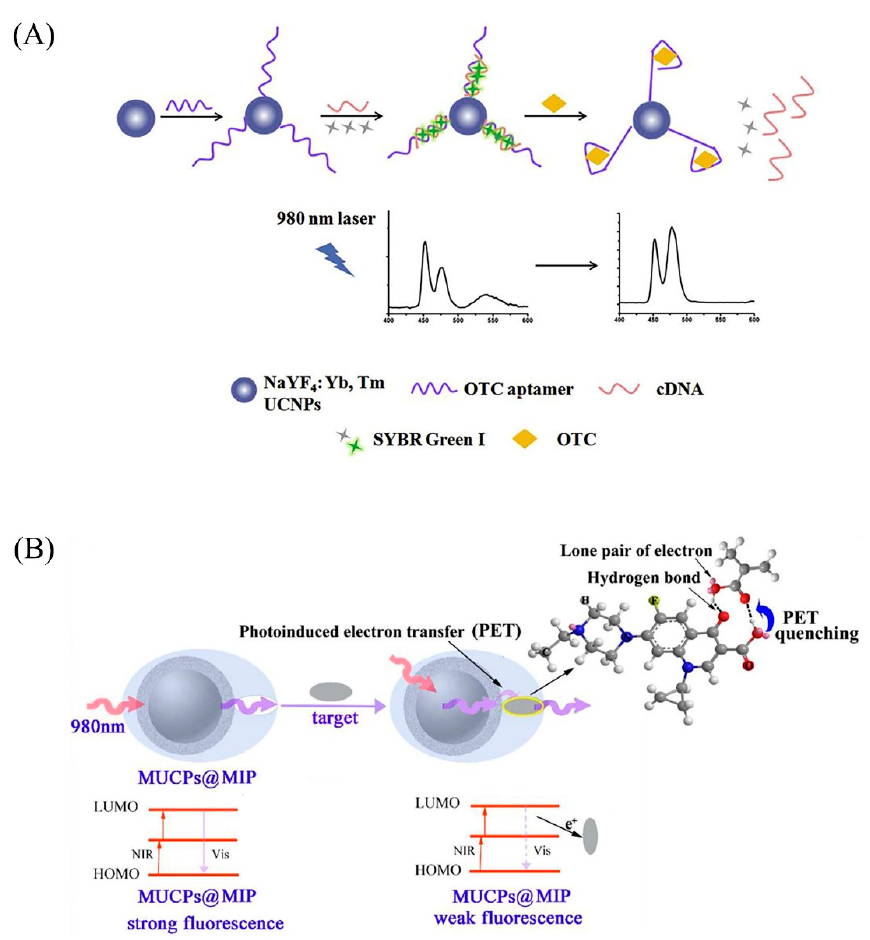
Figure 7. ( A ) Schematic illustration of the sensitive aptasensor for oxytetracycline based on upcon- version luminescence resonance energy transfer. ( B ) Schematic diagram of quinolones fluorescence quenching the UCNPs mechanism. Reprinted with permission from [60,65]. Copyright 2015 and 2018, Elsevier.